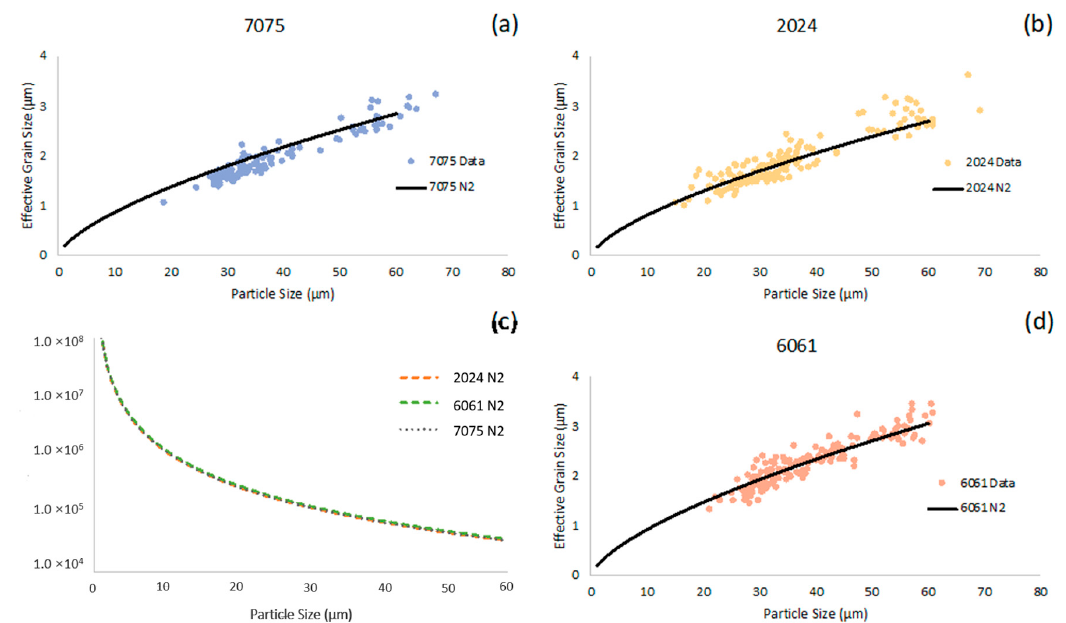
Figure 3. Grain size as a function of particle size, both predicted / theoretical and experimental, for the three alloys studied in the as-atomized state. ( a ) depicts the calculated and experimentally measured Al 7075 gas-atomized powder particle grain sizes as a function of particle size. The same analysis was presented in ( b , d ) for gas-atomized Al 2024 and Al 6061, respectively. Finally, ( c ) presents the calculated cooling rates as a function of particle size for each of the gas-atomized aluminum alloys studied herein.